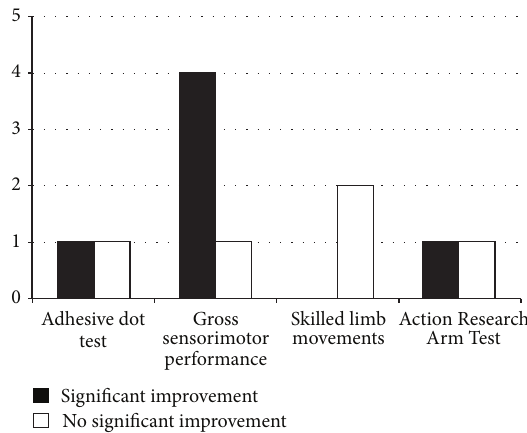
Figure 3: Effects of AE on upper limb movement: significant improvements (black bars) and negative findings (white bars) in animal studies ( 𝑛 = 7 ) and clinical trials ( 𝑛 = 2 ) were subcategorized under specific tasks: adhesive dot test, gross sensorimotor perfor- mance (e.g., forelimb placement test, Garcia index, or the cylinder test), and skilled limb movements (e.g., staircase test). The clinical trials included in this review only assessed performance on the Action Research Arm Test as a measurement of skilled movement of the upper